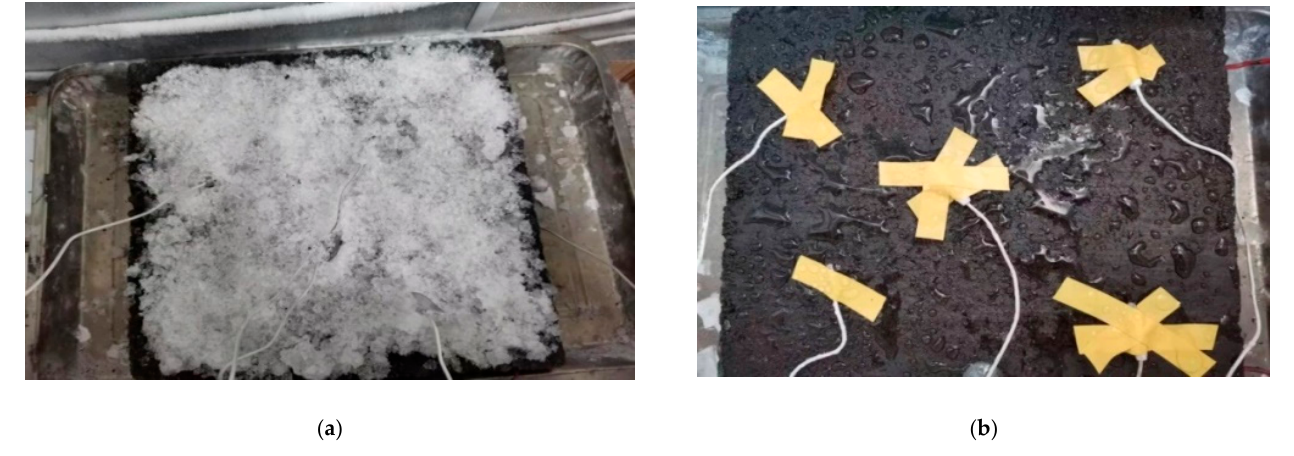
Figure 20. Ice melting test without insulation. ( a ) Ice flower spread; ( b ) Ice flake melting. phalt concrete during the test was recorded as shown in Figure 21.